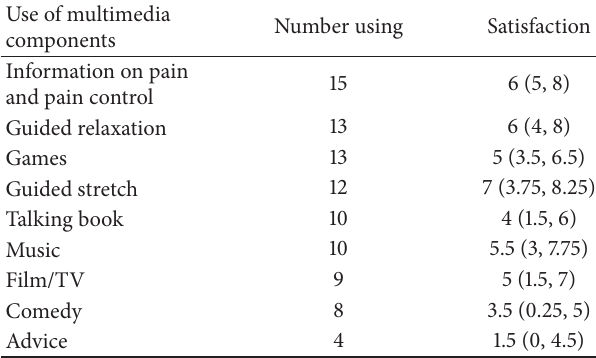
Table 5: Number of patients using each multimedia option and respective satisfaction score out of 10, with interquartile range, for